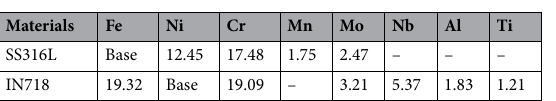
Table 1. Chemical compositions of SS316L and IN718 powders (wt%).